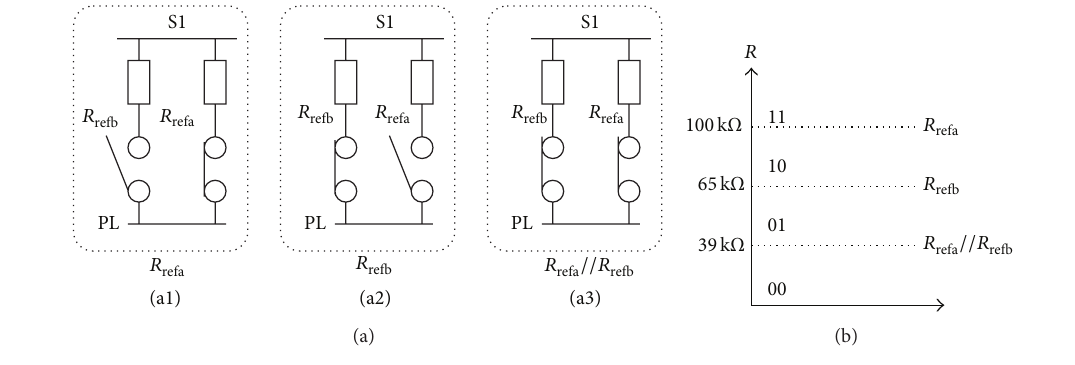
Figure 4: Reference